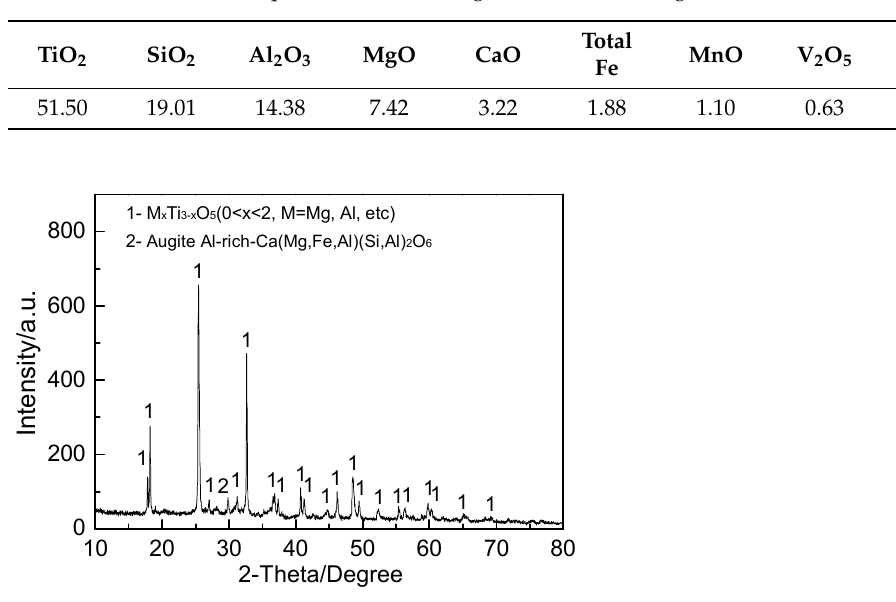
Figure 1. XRD pattern of Ti-bearing electric furnace slag.